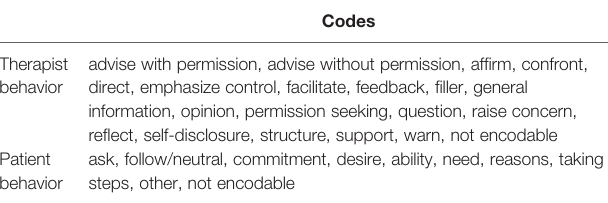
TABLE 2 | Codes for therapist and patient verbal